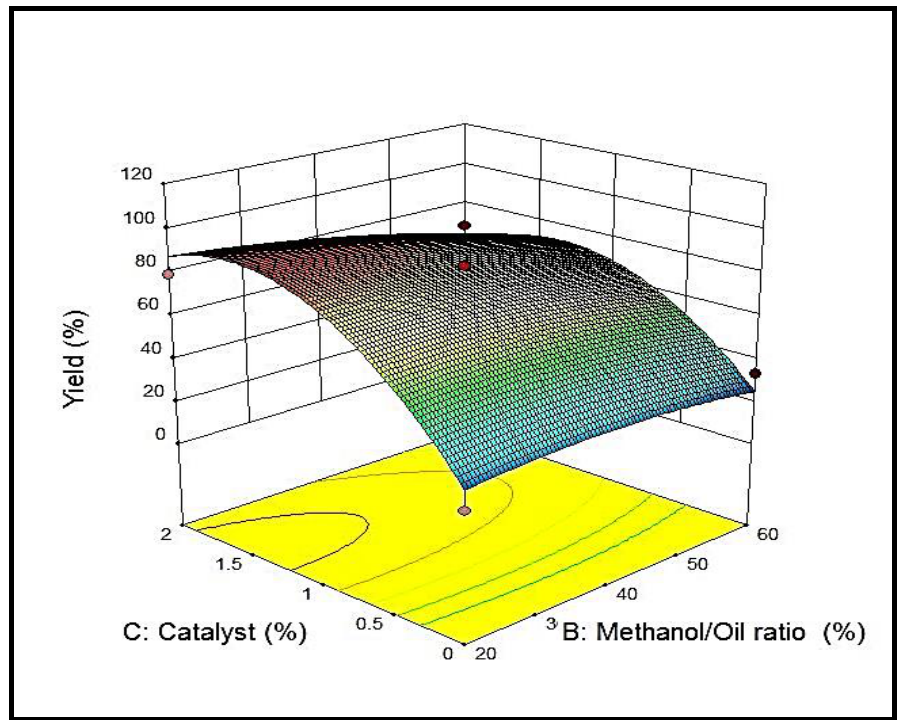
Figure 5. Biodiesel yield (%) vs. CC (%) and methanol/oil ratio (%) .